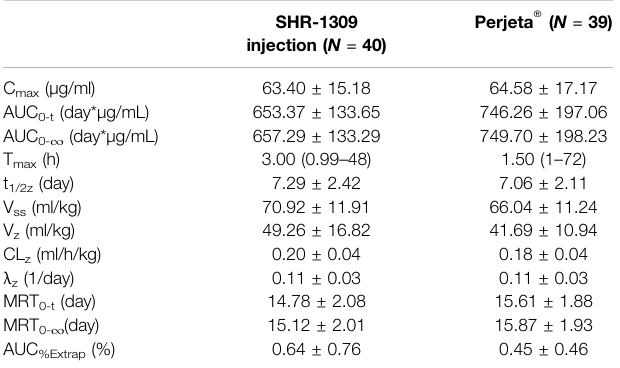
TABLE 2 | The main PK parameters of SHR-1309 injection or Perjeta ® after intravenous drip.